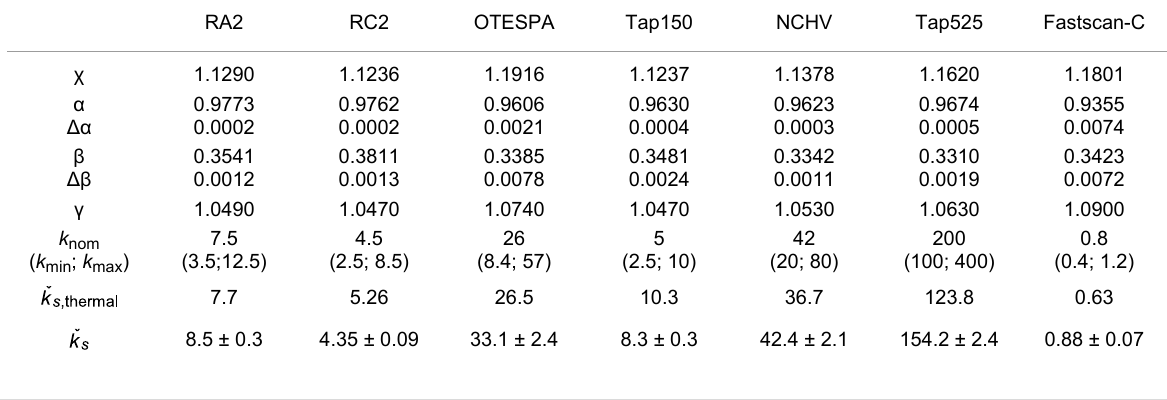
Table 2: Conversion factors with their standard deviations ( Δ ), and nominal (manufacturer quoted) and experimentally determined spring constant values. No individual error estimates are stated for the thermal noise measurements but are typically found to be in the range of 10–20% [14,34]. RA2